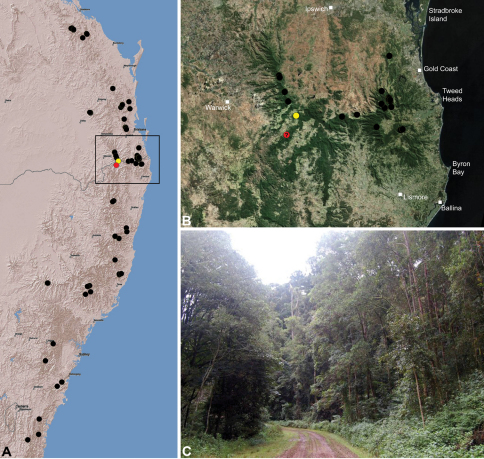
Austrarchaea clyneae sp. n., distribution and habitat: A, topographic map showing the known distribution of Archaeidae in south-eastern Queensland and eastern New South Wales, with collection localities for A. clyneae highlighted in yellow (red highlighted localities denote juvenile specimens of tentative identification); B, satellite image showing detail of inset (A); C, subtropical rainforest at the type locality – Mount Clunie National Park, Queensland (June 2008). Image (C) by A. Rix, used with permission.